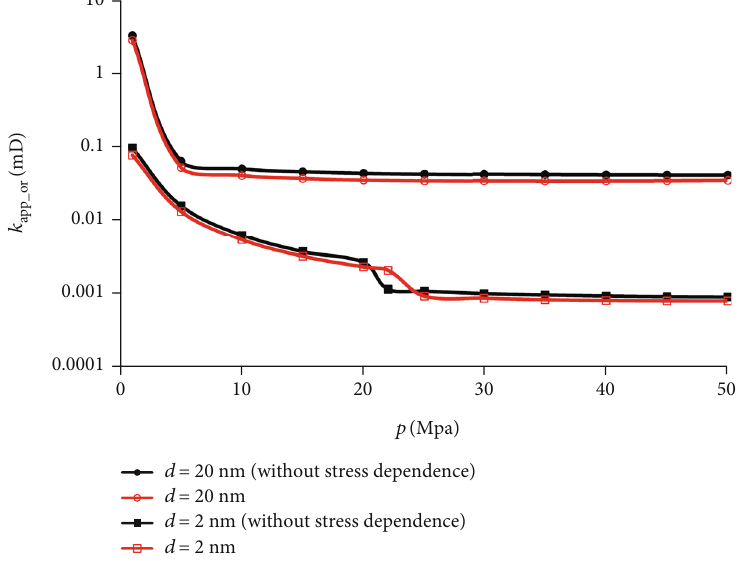
Figure 5: Organic pore AGP curves with and without considering the stress